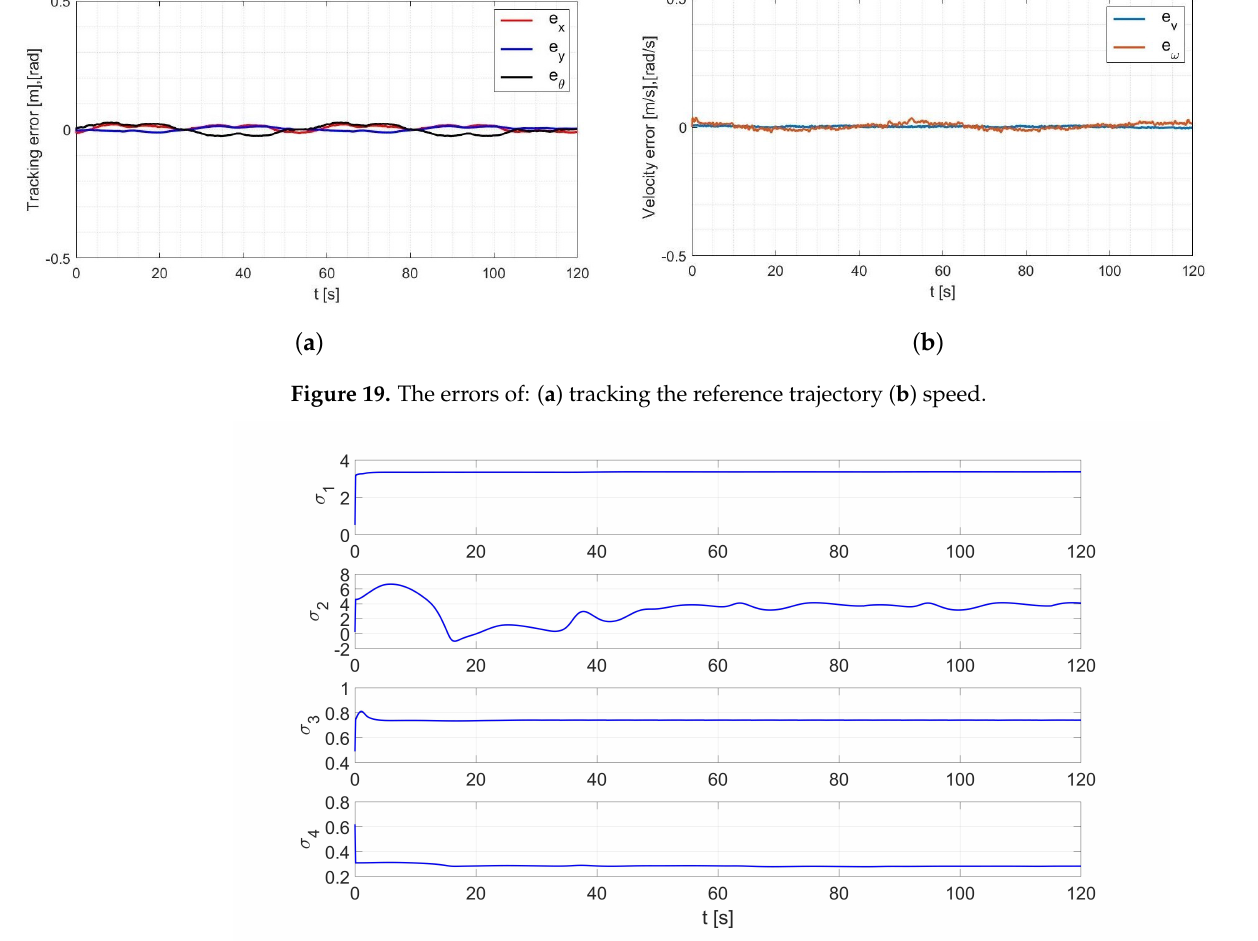
Figure 20. Distribution of parameters identified online by the RLS method with random values of initial parameters in the laboratory